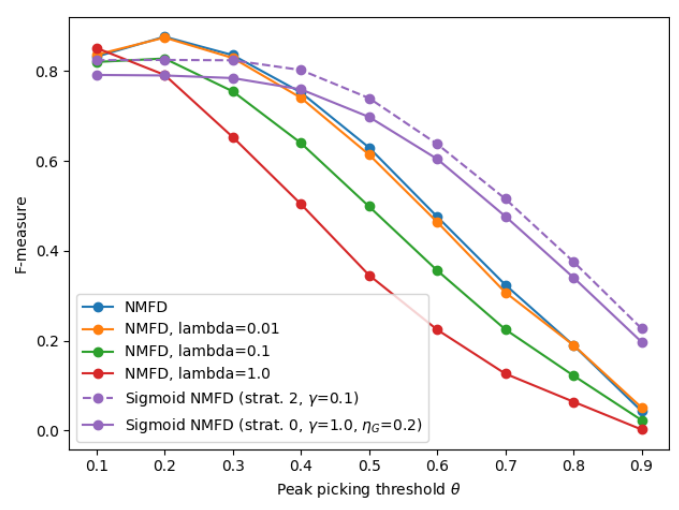
Figure 3. Onset coverage F-measure as a function of the peak picking threshold θ thr